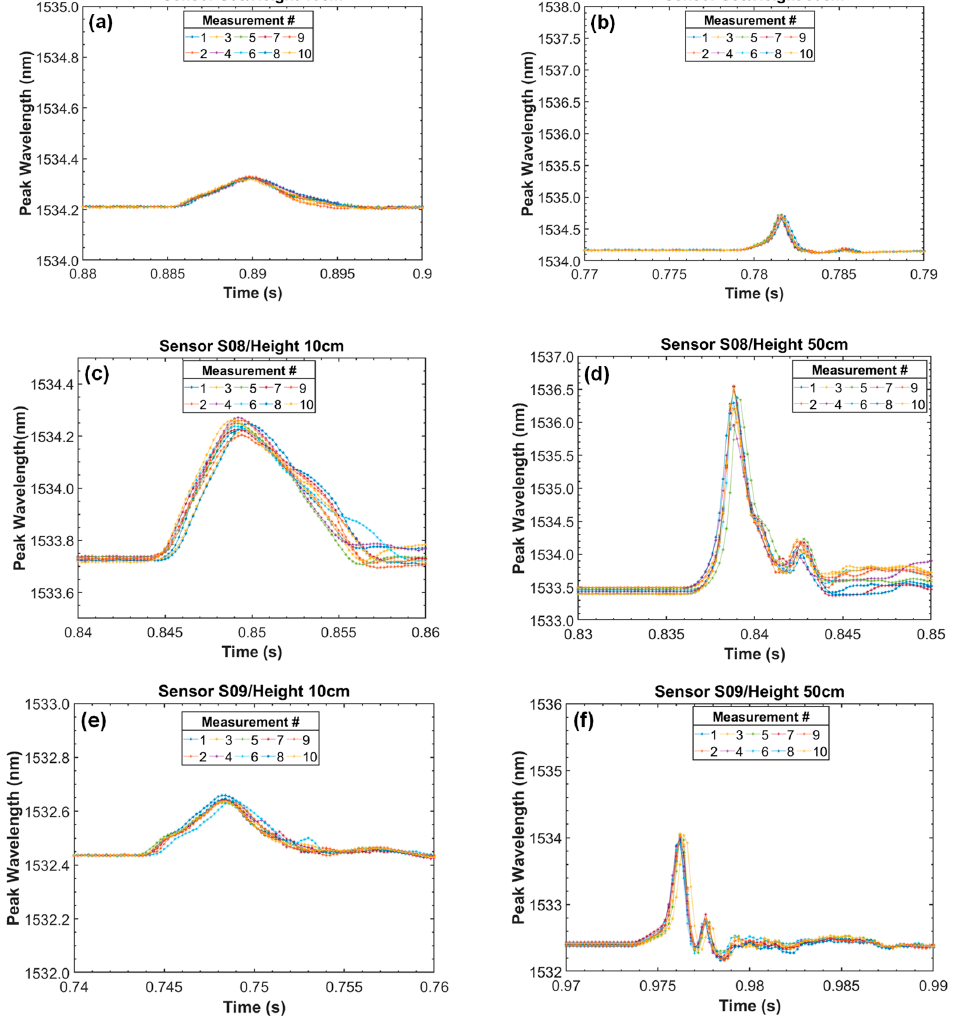
Figure 10. Results of dynamic tests performed using free fall height, for ( a ) TB (S05) 10 cm, ( b ) TB (S05) 50 cm, ( c ) PEEK (S08) 10 cm, ( d ) PEEK (S08) 50 cm, ( e ) PEEK (S09) 10 cm and ( f ) PEEK (S09) 50 cm.